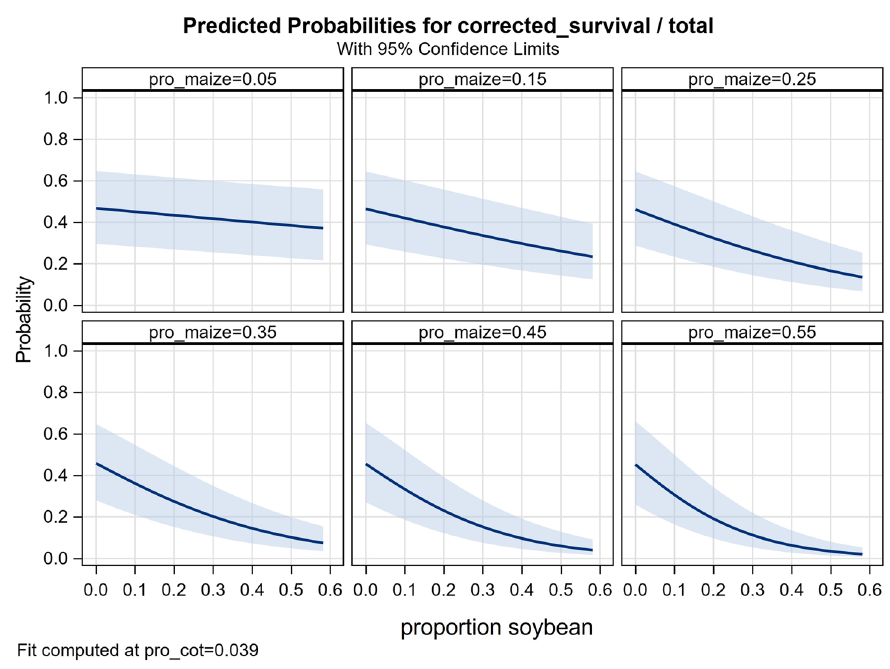
Figure 4. Predicted survival of H. zea larvae in response to proportional areas of soybean at six levels of proportional abundance of maize during the prior year within a 1-km radius of the collection site. Proportional abundances of maize shown (0.05; 0.15; 0.25 0.35; 0.45; 0.55) were selected to illustrate changes in response to maize abundance across the range observed in our study (0.01 to 0.54). Data provided in Table S2. Fit is computed at the mean proportional area of cotton (0.039). Shaded bands are